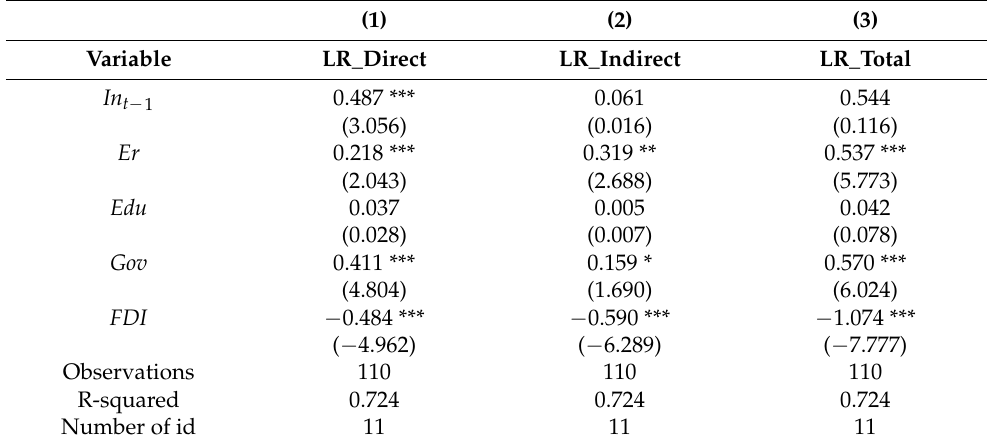
Table 6. Estimates for eastern regions.